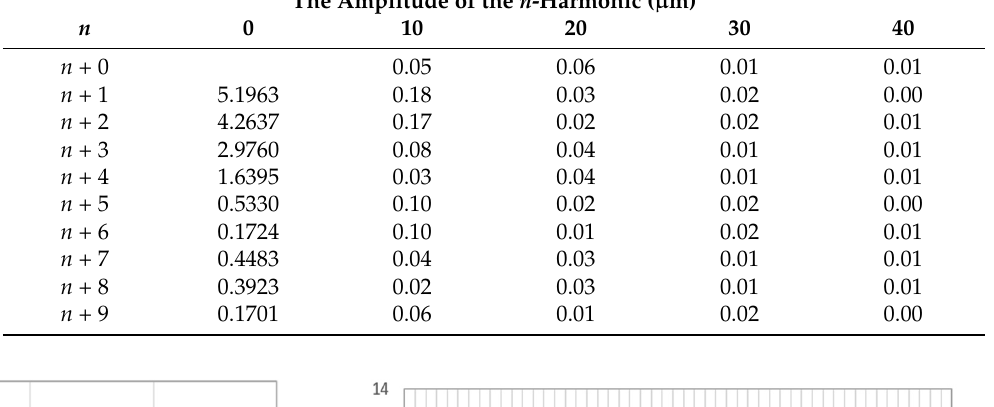
Figure 13. Picture of the measured outline of eccentricity contained in the summary profile for w = 16.5 µm ( a ), and discrete amplitude spectrum ( b ). Table 3. Values of the amplitudes of the harmonic components of the outline of eccentricity (Figure 13). The Amplitude of the n -Harmonic ( µ m)